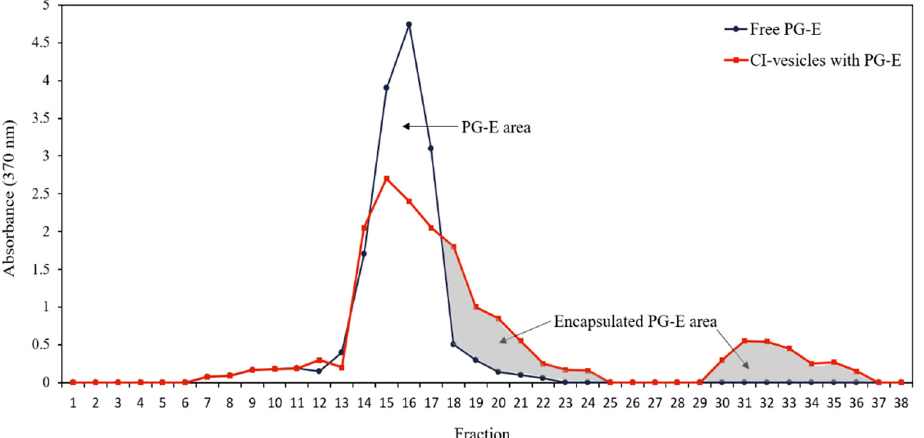
Figure 1. Absorbance (370 nm) of each fraction obtained after passing through a Sephadex column the samples of free PG-E (blue line) and CI-vesicles with encapsulated PG-E (red line). The grey area indicates the proportion of PG-E encapsulated in CI-vesicles. PG-E, pomegranate extract; CI-vesicles, cauliflower inflorescence vesicles.